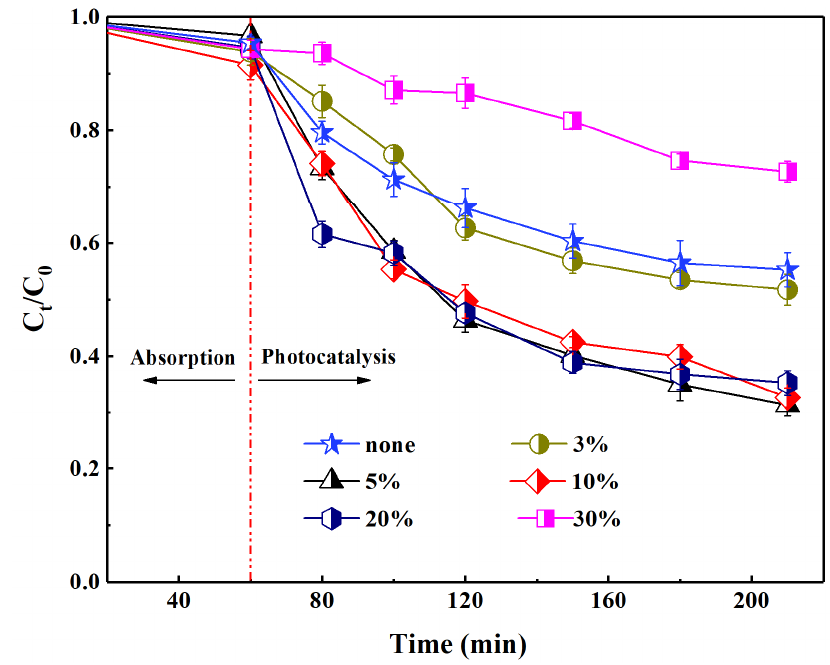
Figure 6. Degradation efficiency of TC versus time with different CD quality fractions.